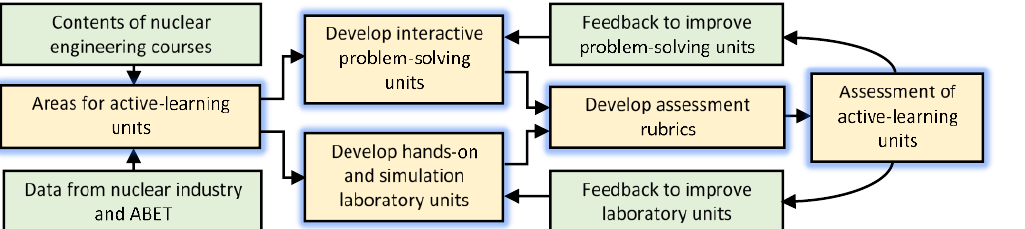
Fig. 1. Approach and methodology for developing and incorporating active-learning units into nuclear engineering courses. ABET is the Accreditation Board for Engineering and